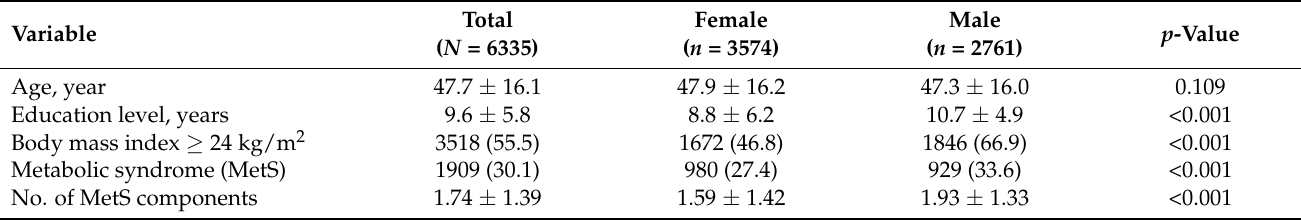
Table 1. Demographic characteristics of the study subjects according to gender ( N =